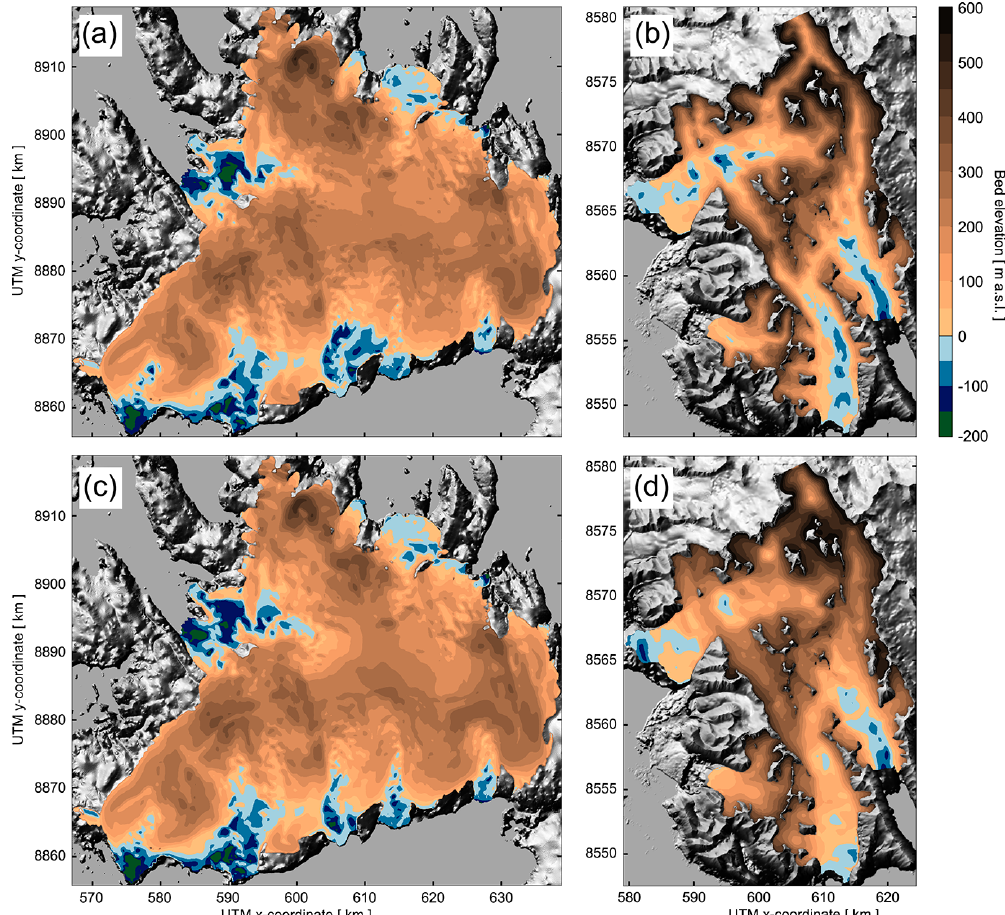
Figure 5. Bedrock topography associated to the thickness field in Fig. 4 for VIC (a, c) , THPB and WSB (b, d) . In absence of direct measurements, negative values over larger areas were not anticipated for Gimlebreen and Idunbreen based on a direct interpolation of thickness data (Pettersson et al., 2011). Upper and lower panels reflect the respective amount of considered thickness measurements as in Fig. 4. Ice-free background: grey-scale hill-shaded topography based on a NPI 50m DEM (http://publicdatasets.data.npolar.no/kartdata/NP_ S0_DTM50.zip). Ice-covered background: grey-scale hill-shaded bedrock